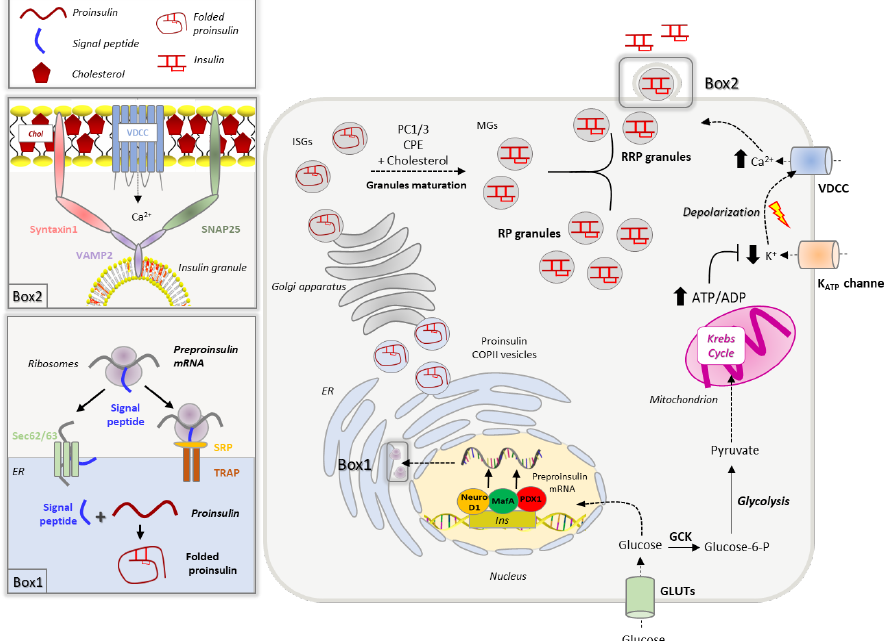
Figure 1. Insulin biosynthesis and secretion. Extracellular glucose is transported in the β -cells through GLUT transporters (GLUT1 in humans, GLUT2 in rodents). Glucose increase promotes the insulin gene transcription, which is controlled by PDX1, MafA and NeuroD1 transcription factors. The insulin transcript crosses the ER membrane via co-translational (SRP and TRAP-dependent) and post-translational (Sec62/63-dependent) translocation processes. Once in the ER lumen, the pre-proinsulin signal peptide is rapidly cleaved to yield proinsulin that undergoes oxidative folding ( Box 1 ). Newly synthesized proinsulin, loaded into COPII vesicles, is then delivered to the Golgi apparatus, where it is sorted to immature secretory granules (ISGs). Granules maturation is associated with increased cholesterol accumulation in the membrane and proinsulin-to-insulin conversion mediated by prohormone convertases 1/3 (PC1/3) and carboxypeptidase E (CPE). Mature granules (MGs) are sorted into two different pools: the readily releasable pool (RRP) docked to the plasma membrane and the reserve pool (RP). Insulin secretion is promoted by the GCK-mediated phosphorylation of glucose, which is then metabolized via glycolysis and Krebs cycle, leading to an increase of ATP production. The elevation of ATP/ADP ratio promotes the closure of K + ATP channels, membrane depolarization and activation of voltage-gated Ca 2+ channels (VDCC). The increase of